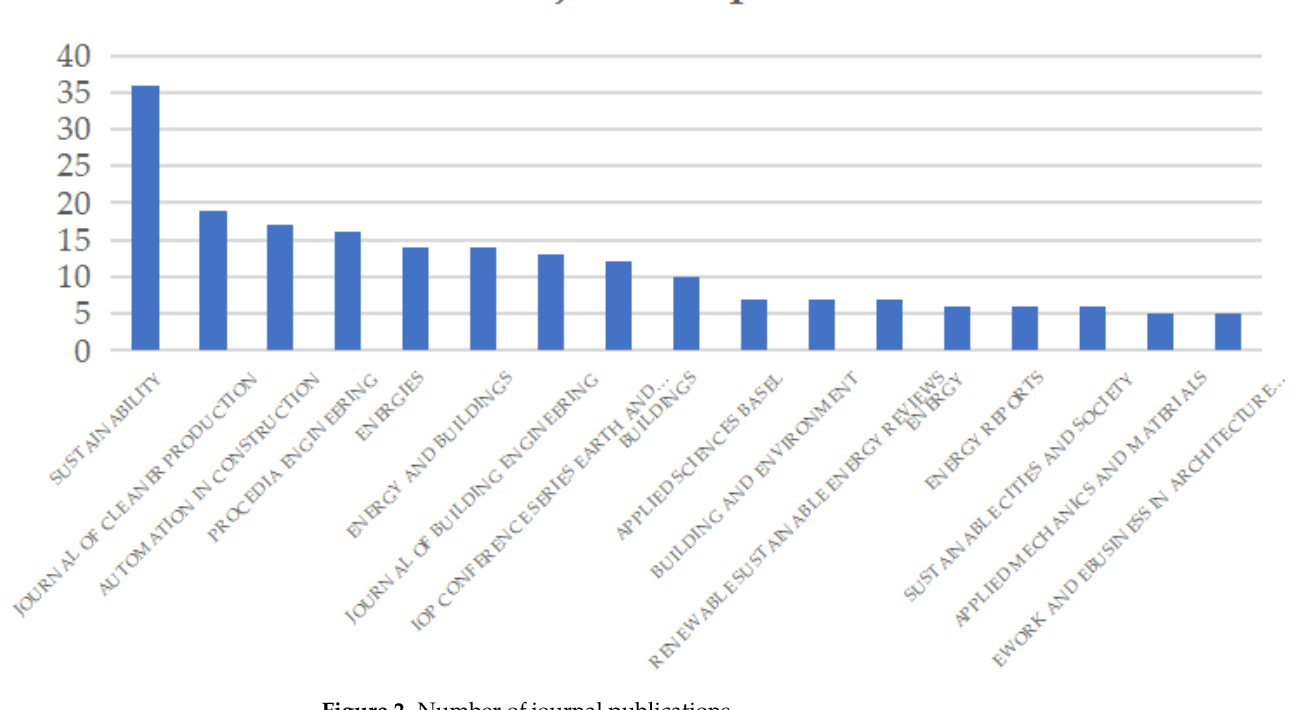
Figure 2. Number of journal publications. Table 1. Number of journal